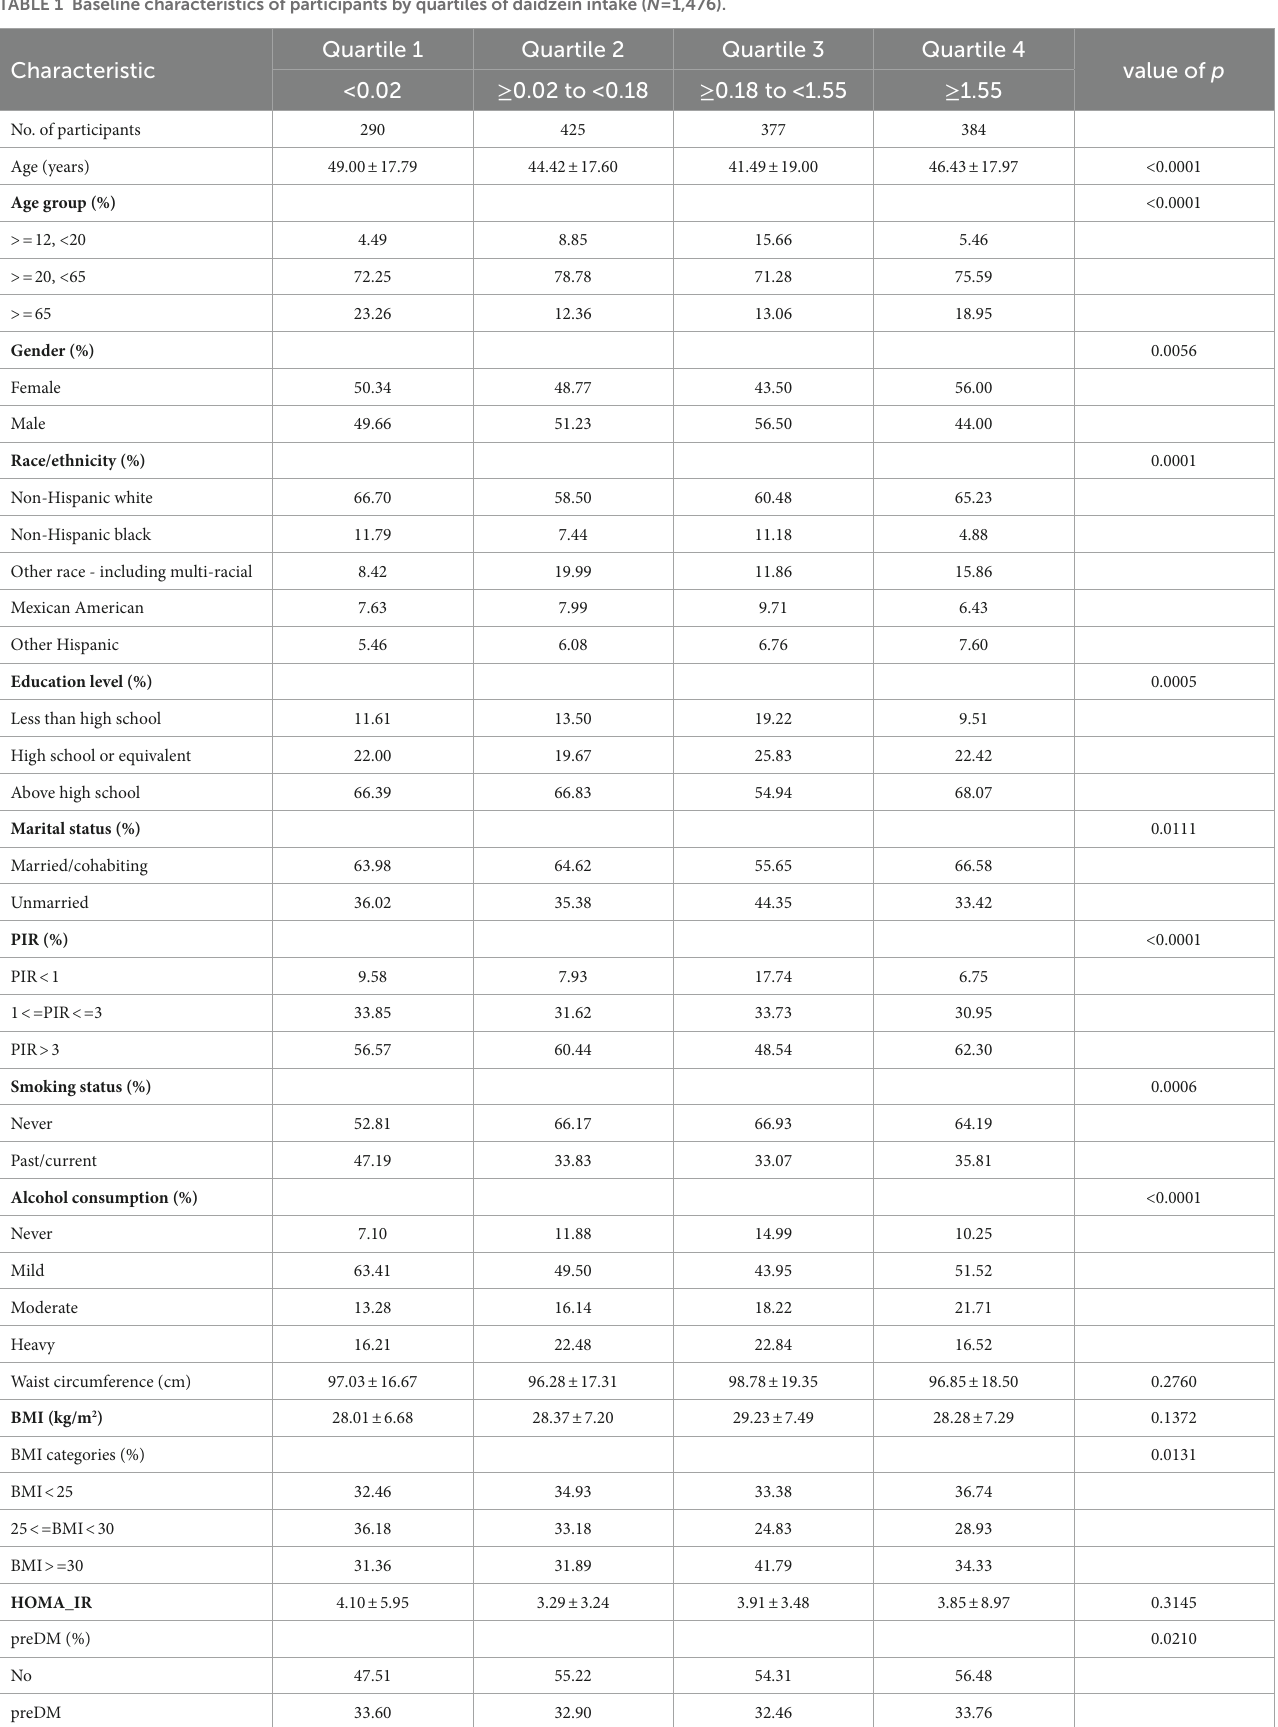
TABLE 1 Baseline characteristics of participants by quartiles of daidzein intake ( N = 1,476). Quartile 1 Quartile 2 Quartile 3 Quartile Characteristic